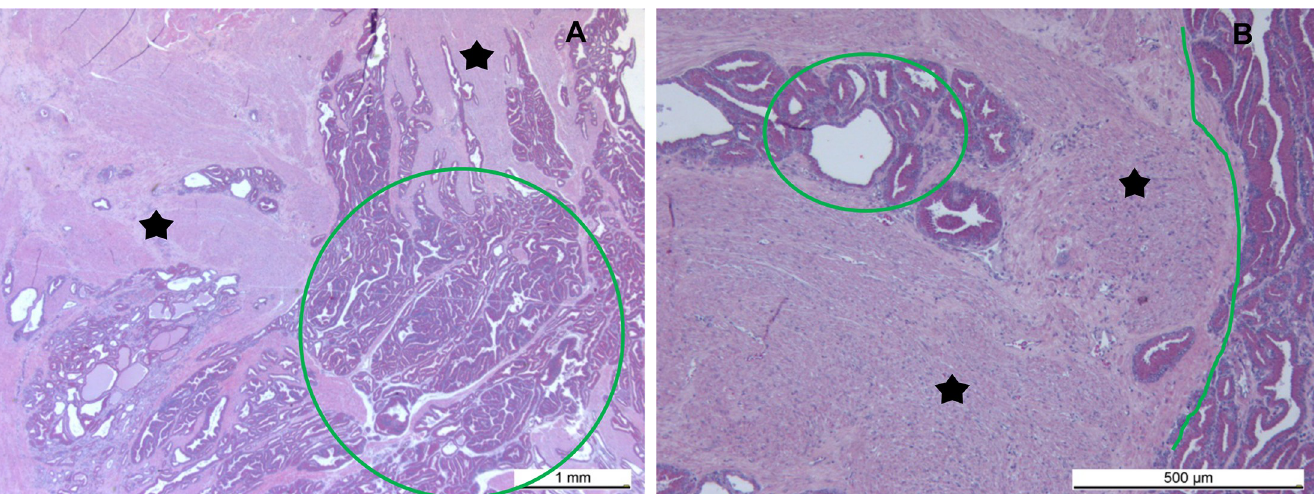
PLOS ONE | https://doi.org/10.1371/journal.pone.0226764 December23,